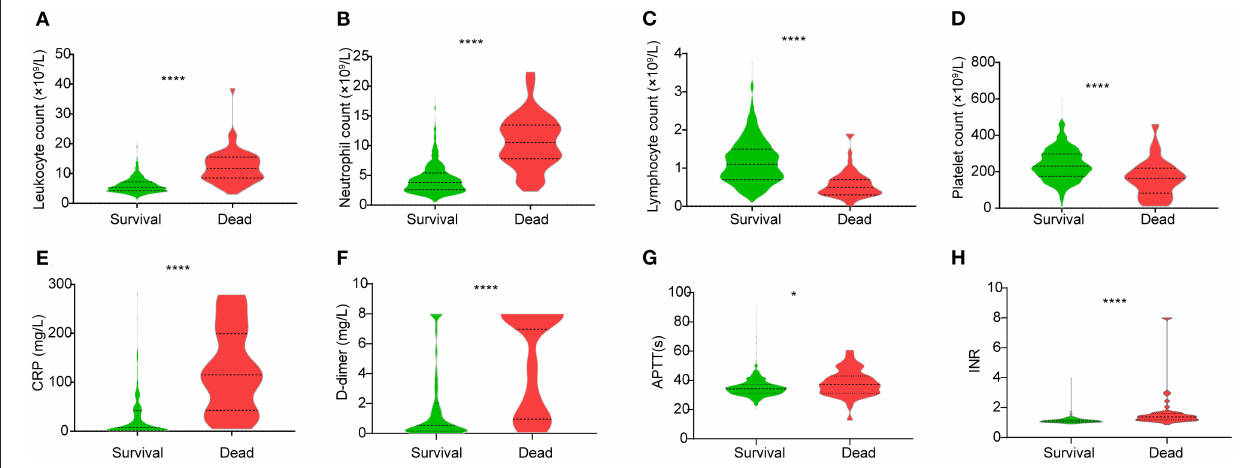
FIGURE 1 | Different levels of hematologic indices (A) leukocyte count, (B) neutrophil count, (C) lymphocyte count, (D) platelet count, (E) CRP level, (F) D-dimer level, (G) APTT, and (H) INR between the discharged and deceased patients. Data are shown as a violin plot with median and 25 and 75% percentile lines. * P < 0.05, **** P < 0.0001. CRP, C-reactive protein; APTT, activated partial thromboplastin time; INR, international normalized ratio.